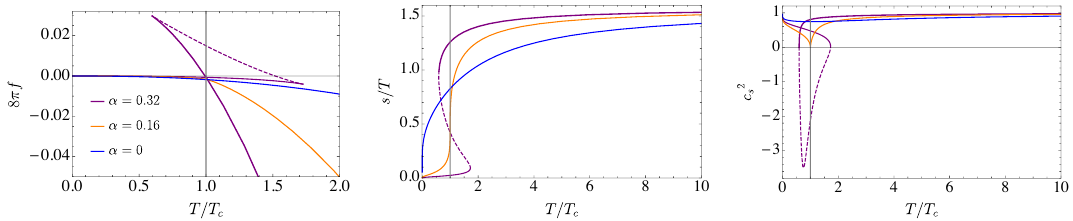
Figure 2 . Free energy density (left), entropy density over temperature (center), speed of sound squared (right). Blue: crossover ( α = 0 ). Orange: second order phase transition ( α = 0 . 16 ). Magenta: first order phase transition ( α = 0 . 32 ). Vertical gray: locus of phase transition. Dashed: thermodynamically unstable solutions with imaginary speed of